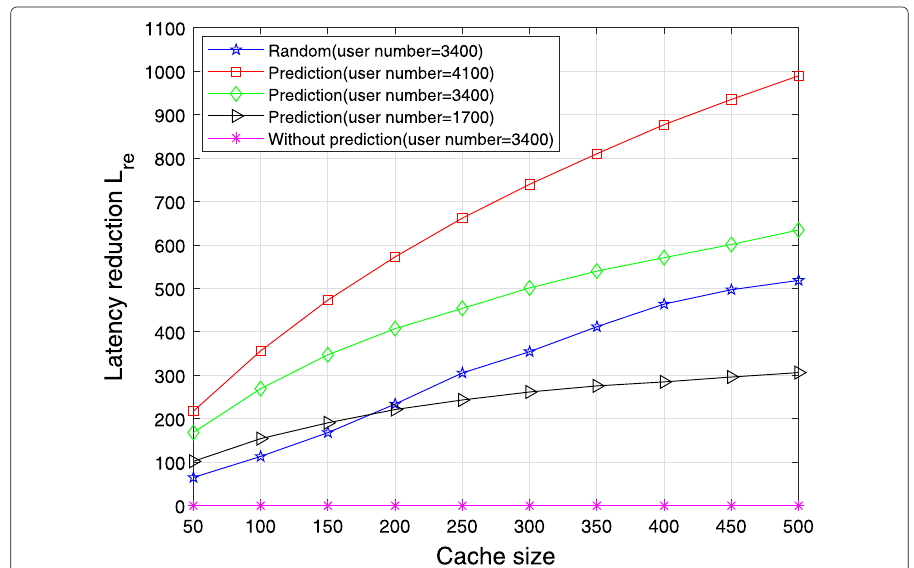
Fig. 8 Latency reduction versus cache size of the BS